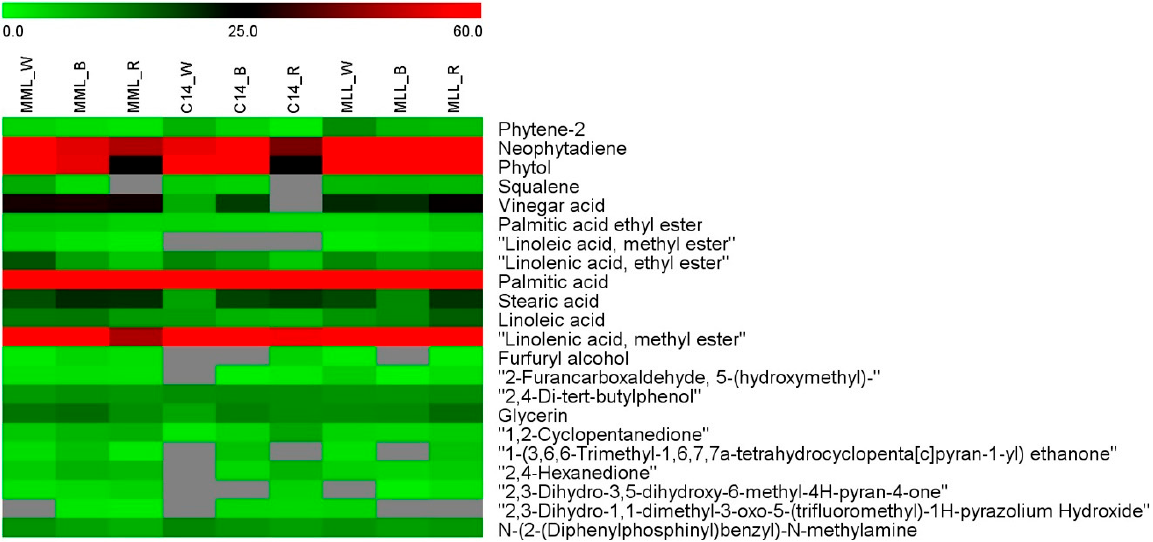
Figure 4. Heatmap demonstrated variations in metabolic profiles detected in leaves of three M. alba L. cultivars after exposure to different light spectra for 7 days. Relative abundance of the compounds was represented as a relative content (%). Green color indicates low amounts of compounds, whereas those with high amounts are colored